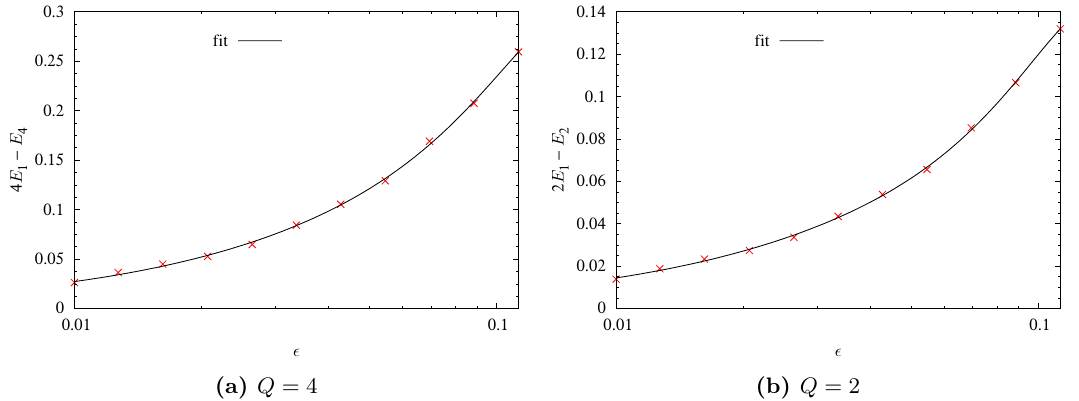
Figure 12. Binding energies for (a) the Q = 2 + 2 bound state solution of figure 5 and (b) of the Q = 1 + 1 bound state solution of figure 8. The fits are shown in the text. Here m 1 = 0 . 5